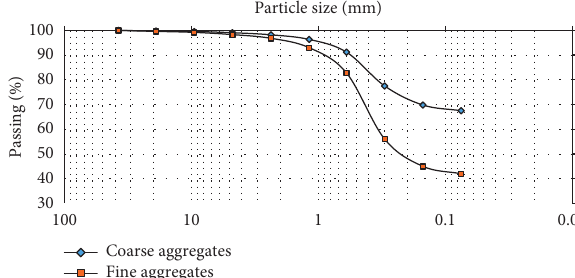
Figure 2: The particle size distribution of aggregates used in the